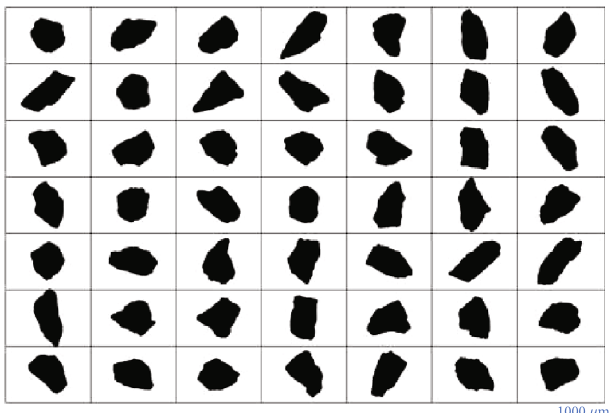
Figure 3: Coal particles photographed by a dynamic image analyzer.